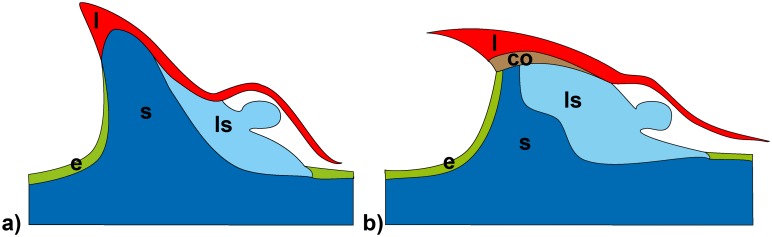
Schematic interpretation of the spine structures in Asparagus falcatus and Asparagus setaceus.The interpretation of the spine structures (a): Asparagus falcatus, b): Asparagus setaceus) is derived from longitudinal sections at different planes in different specimens. l: leaf tissue, s: stem tissue (including thick-walled lignified cells), ls: lateral shoot tissue, e: epidermis, co: cork layer.